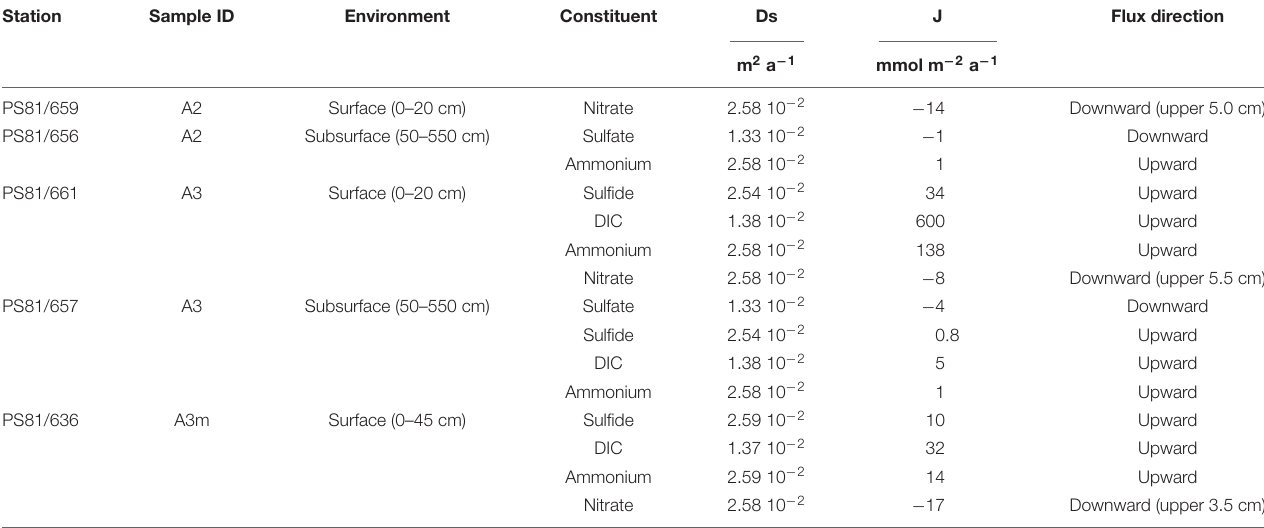
TABLE 2 | Diffusive flux rates (J) of various geochemical constituents in the SWIR ridge valley areas A2 and A3. Station